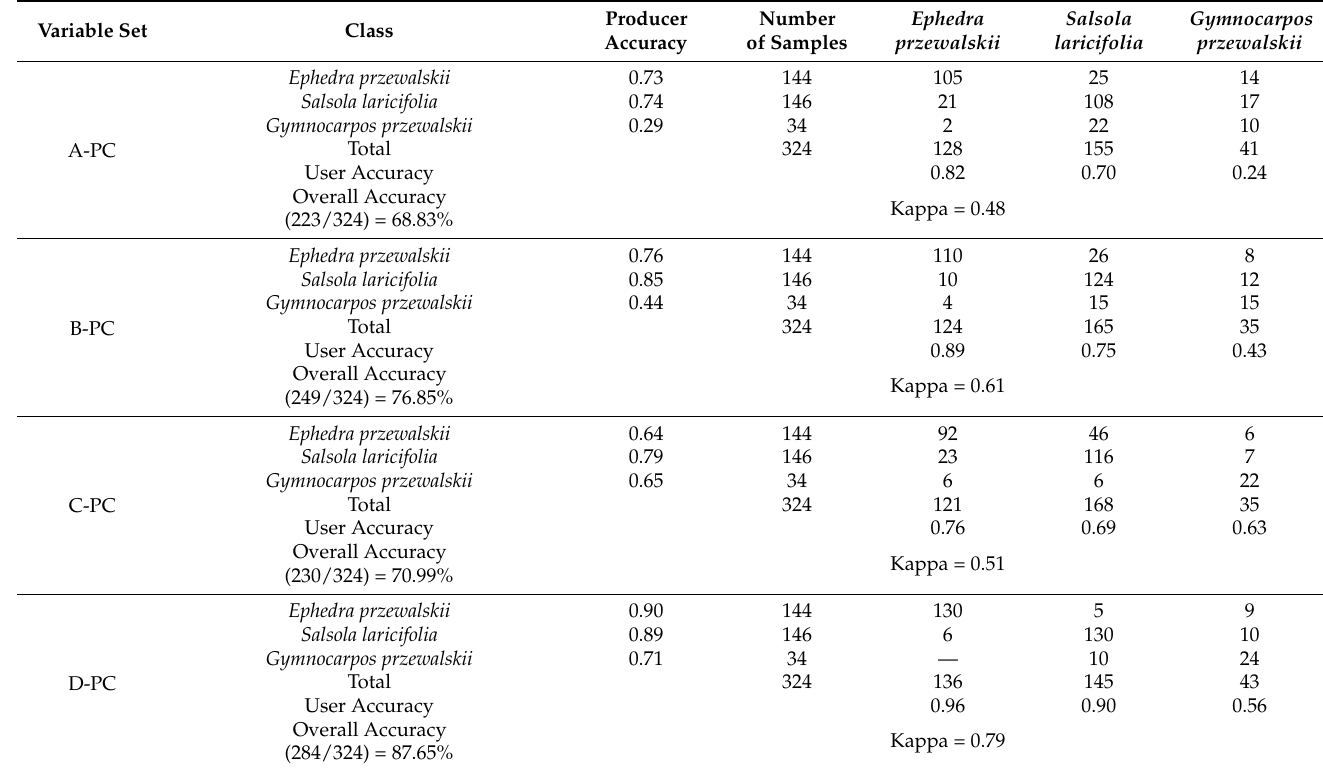
Table A7. Comparison of classification accuracies of individual shrub species maps from EPPR–SALA–GYPR alliance of four sets of variables generated by the random forest (RF)